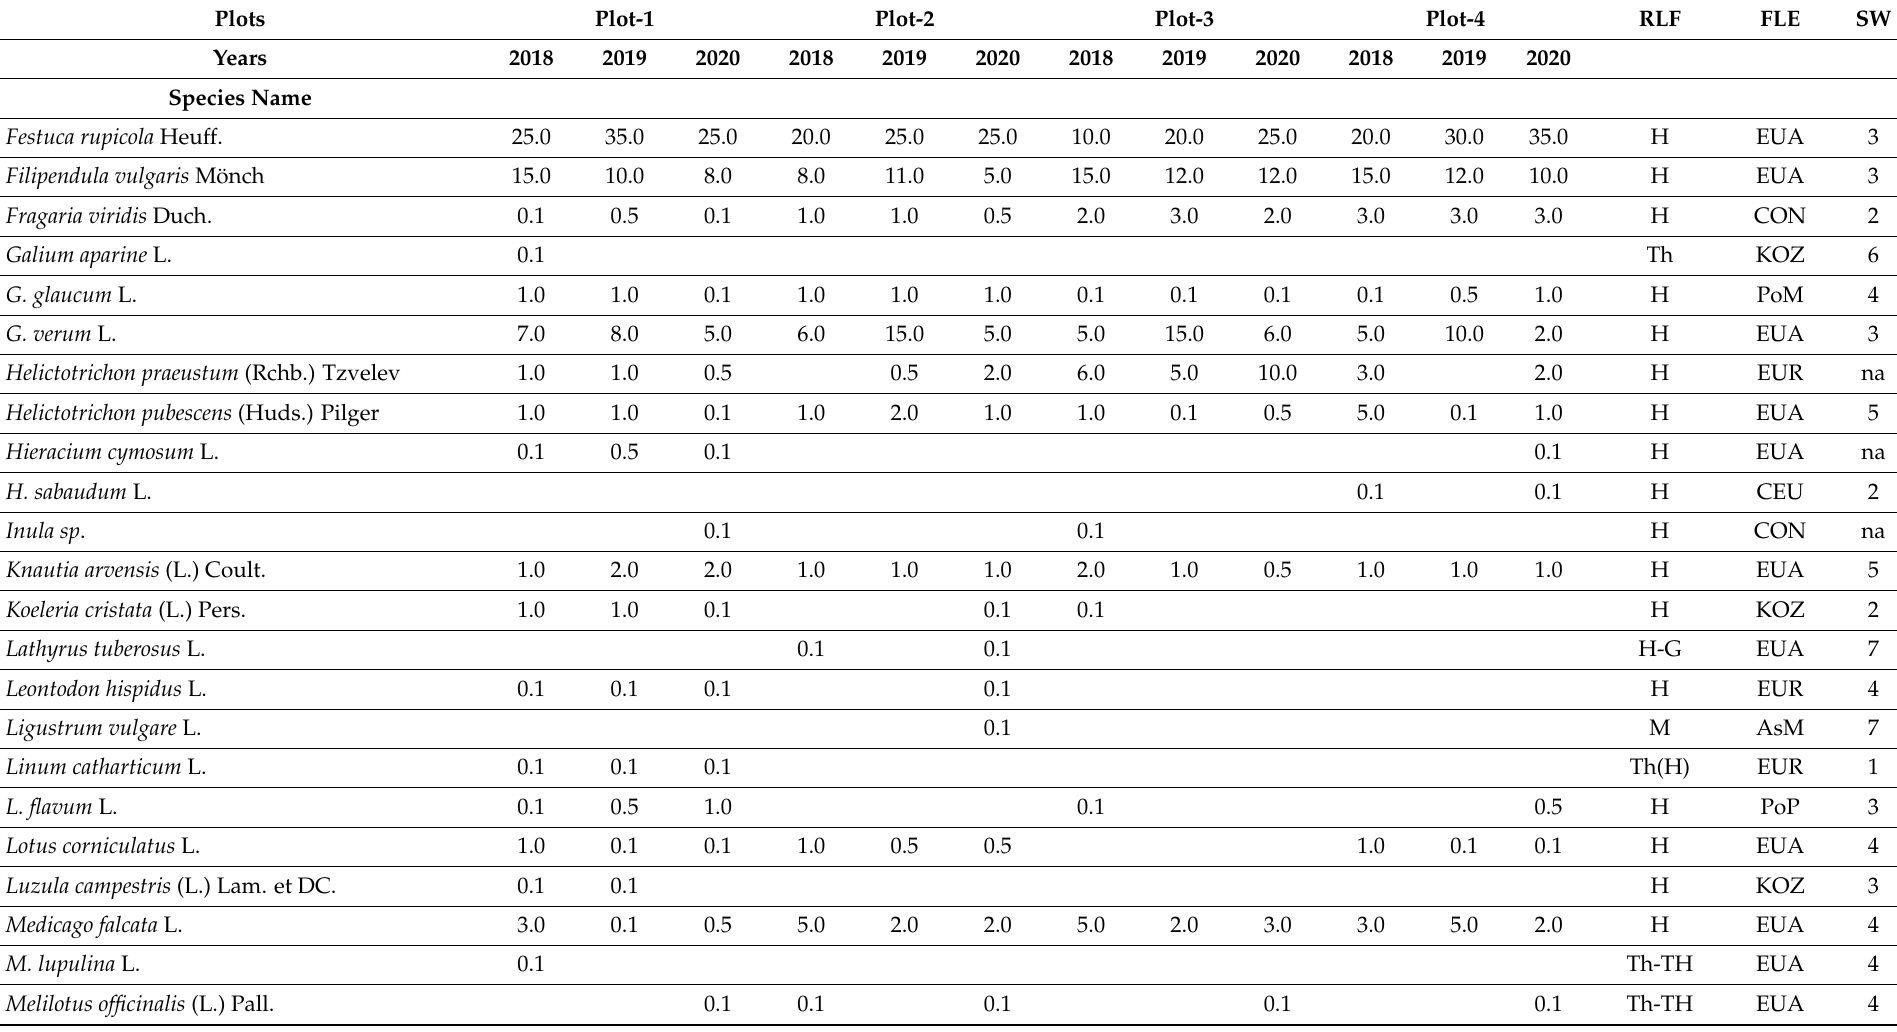
Table A1. Cont. Plots Plot-1 Plot-2 Plot-3 Plot-4 RLF FLE SW